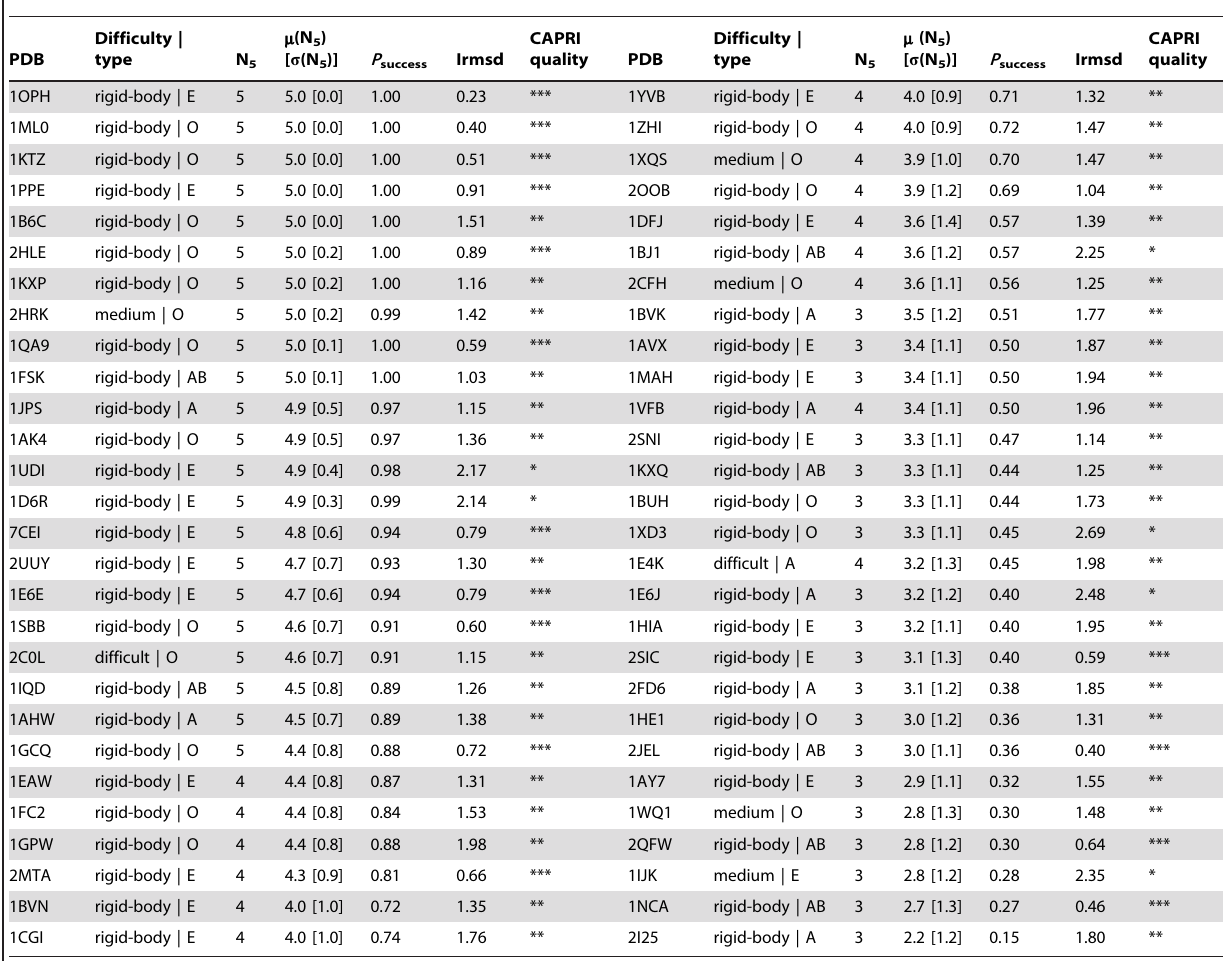
Table 2. Docking Benchmark 3.0 results summary for